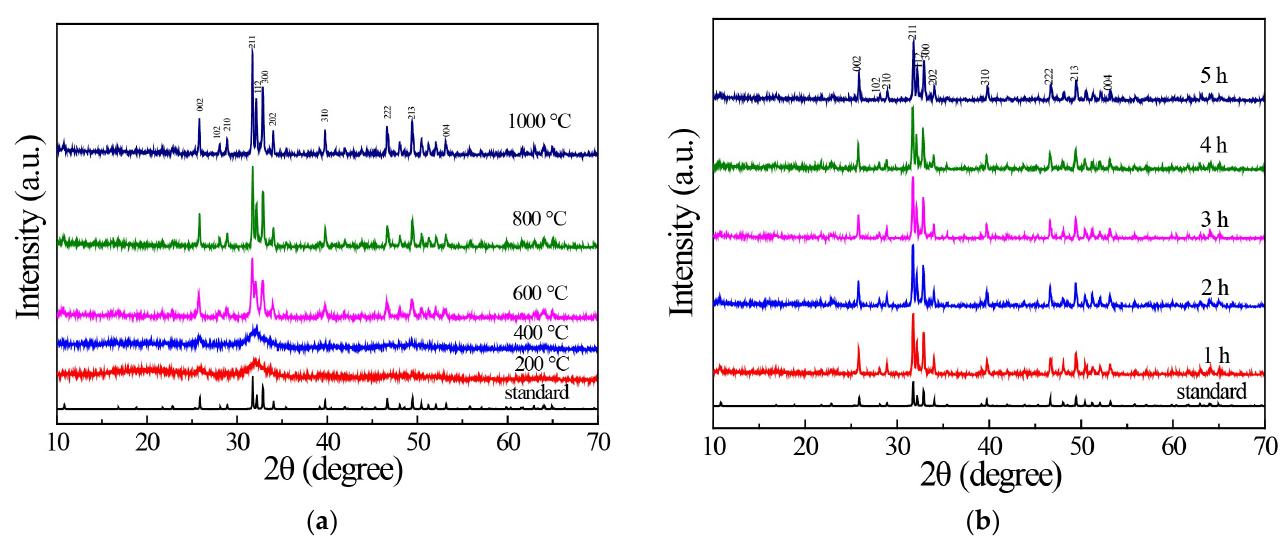
Figure 2b. From the above, it can be concluded that when the calcination temperature reaches 600 ◦ C, the organic matter in the fish scale can decompose, so we can obtain a relatively pure HAP sample.